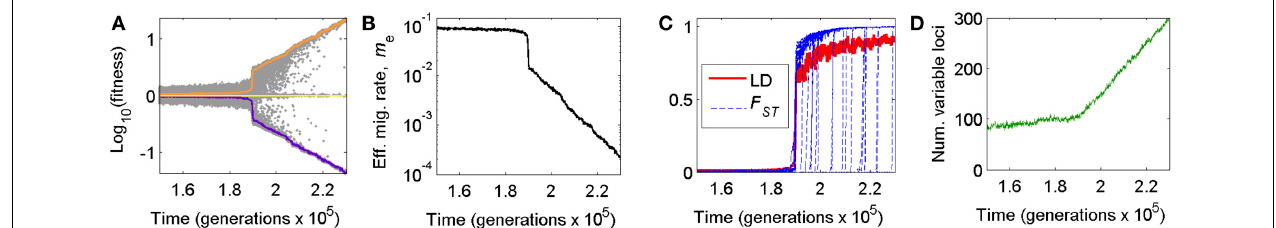
from divergent local adaptation, during the transition into GWC. (C) The genome-wide average of linkage disequilibrium (LD) for pairs of loci on different chromosomes (single, red line) and F ST values (blue lines) over time for a random subsample of loci, depicting dramatic rises in these metrics of divergence accompanying GWC. (D) Jump in the rate of accumulation of divergently selected alleles as GWC occurs. Plots were produced from one example simulation run of the BU2S model (Methods; see also Flaxman et al., 2014) with N = 20 , 000 individuals, m = 0 . 1, s = 0 . 01, and no inverted regions in the